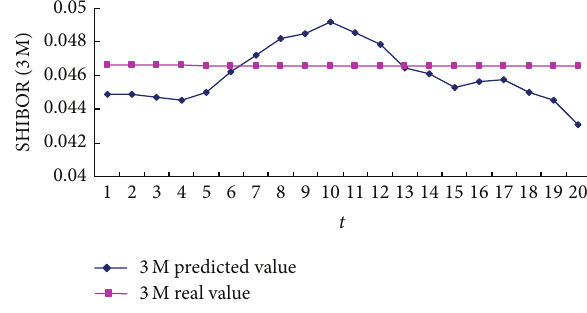
Figure 5: Three-month SHIBOR forecast figure.